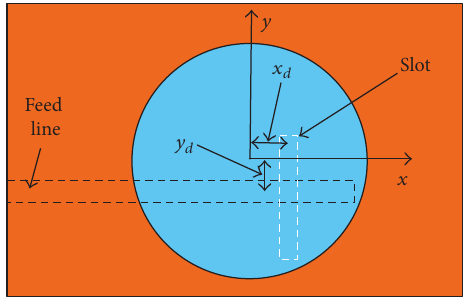
Figure 12: Top view of an aperture-coupled hemispherical DRA as presented in [20].